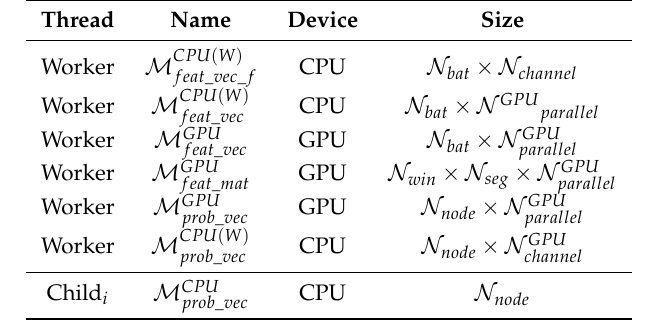
Figure 4. Main procedure of the proposed fast multichannel parallel acoustic score computation using a CSC BLSTM AM. The green- and blue-shaded boxes indicate a CPU memory and a GPU memory, respectively. Table 3. Summarization of the allocated run-time memories at CPU and GPU of the proposed fast multichannel parallel acoustic score